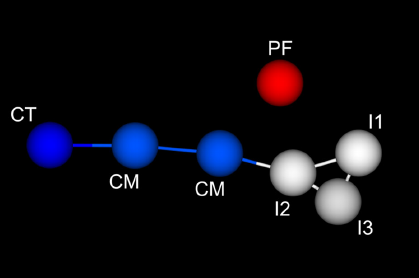
of the coarse-grained